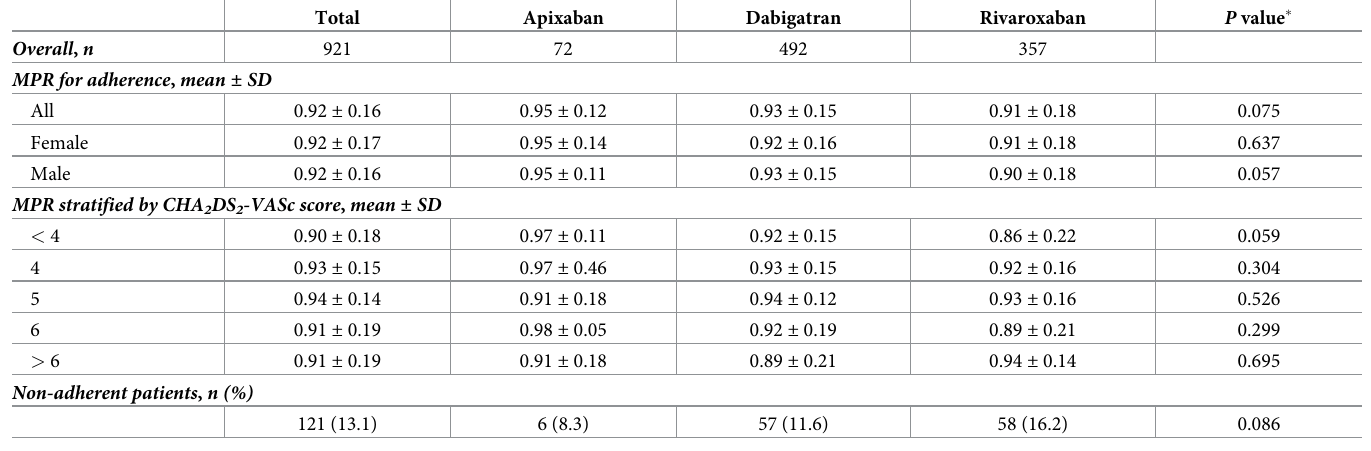
Table 4. Medication adherence to direct oral anticoagulants in patients with atrial fibrillation aged over 65. Total Apixaban Dabigatran Rivaroxaban P value